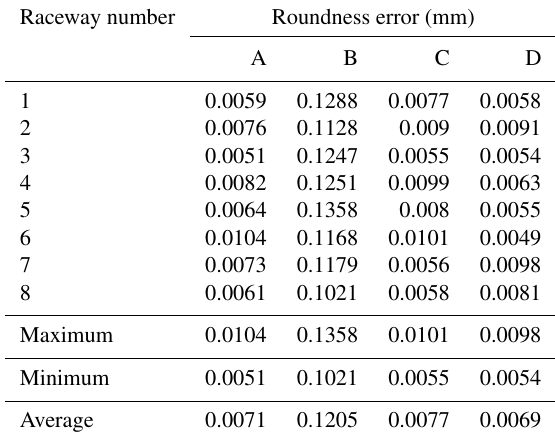
Table 5. Roundness